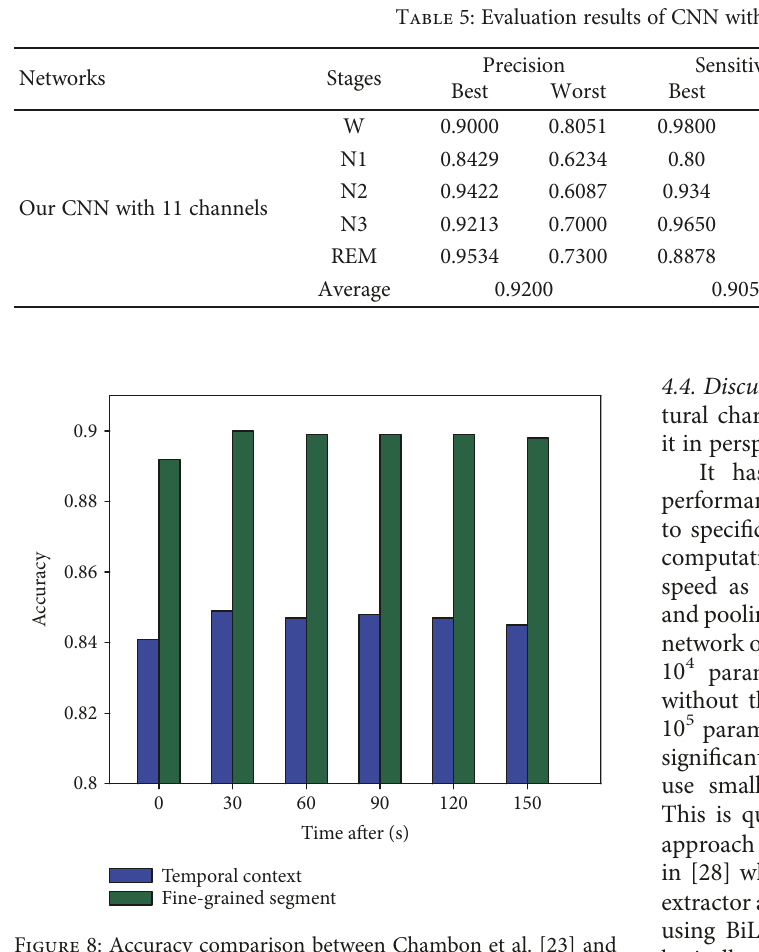
Figure 8: Accuracy comparison between Chambon et al. [23] and our CNN under di ff erent sizes of k